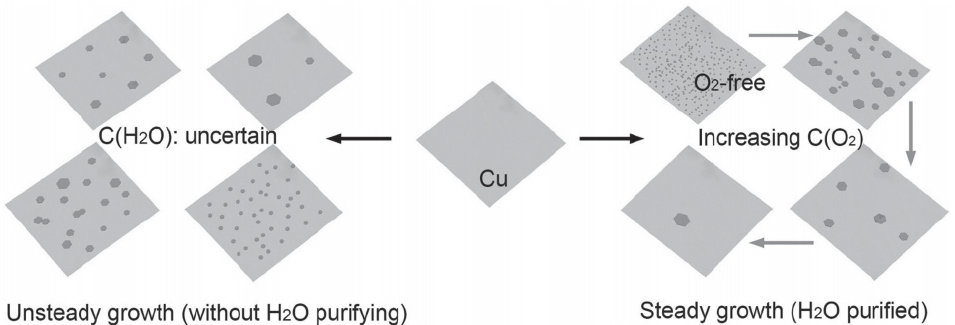
Figure 1. Illustration of grown graphene from different CVD processes. C (H 2 O) and C (O 2 ) represent the concentration of H 2 O vapor impurities and introduced O 2 , respectively [28]. Reprinted with permission from ref. [28]. Copyright 2016 WILEY-VCH Verlag GmbH & Co. KGaA.